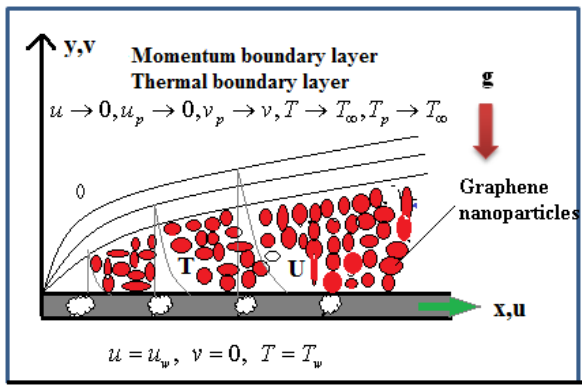
field of strength B along the y -axis which generates mag- 0 netic field effect in perpendicular ( x ) direction. The sim- ulation is performed by mixing of graphene +water into dusty nano fluid. We considered Nano and dust particles are to be spherical in shape. Throughout the flow prob- lem number density of the dust particles are considered to be constant and volume fraction of dust particles is ne- glected. The drag force is taken into consideration for the fluid and particle interaction. Stokes linear drag theory is used to model the drag force. The wall and the ambient temperatures are T ( x , t ) and T ∞ w